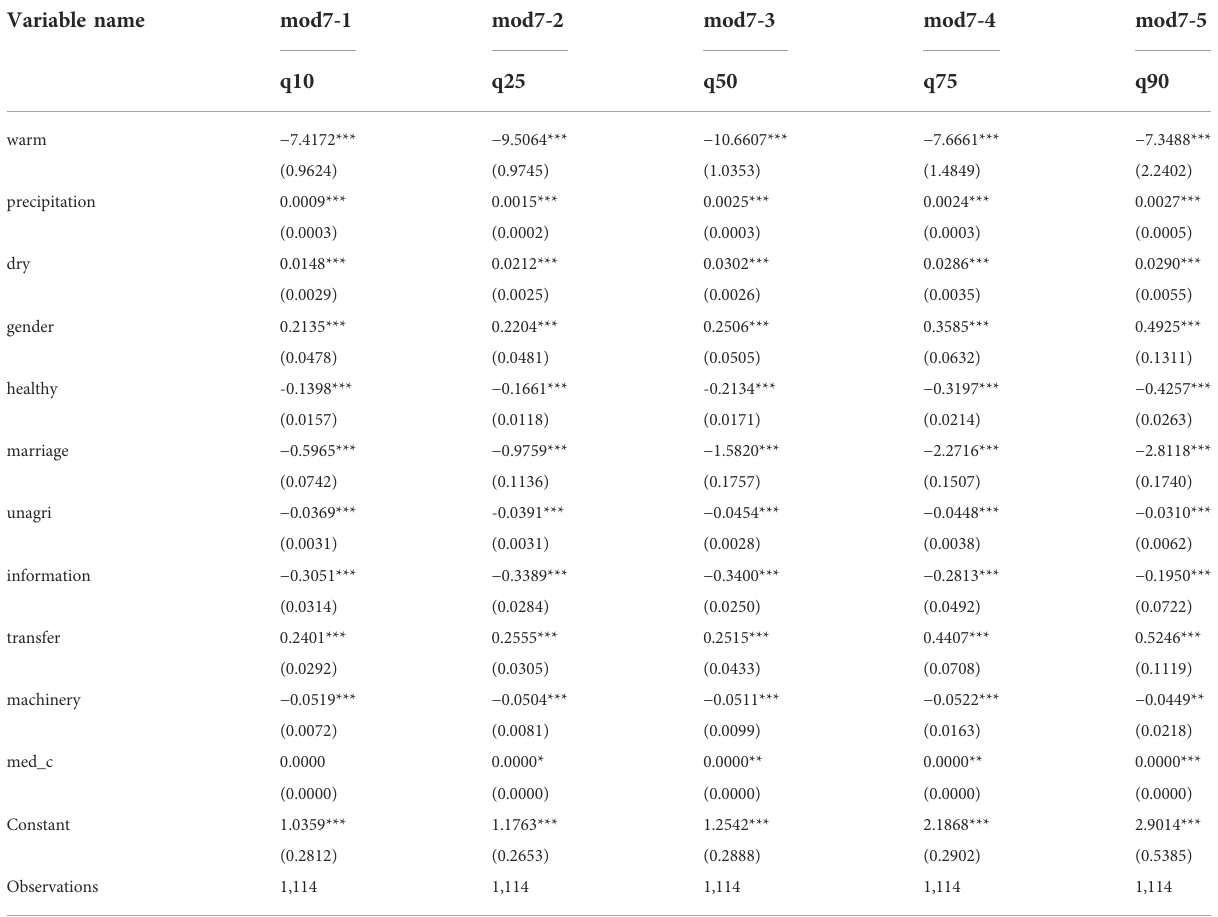
TABLE 7 Impact of extreme weather on farm households with different levels of poverty vulnerability (poor = RMB